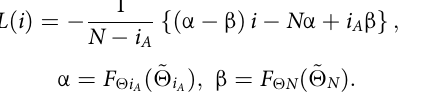
FIGURE 9 | Identified shear and bending stiffnesses in non-simultaneous measurement using empirical